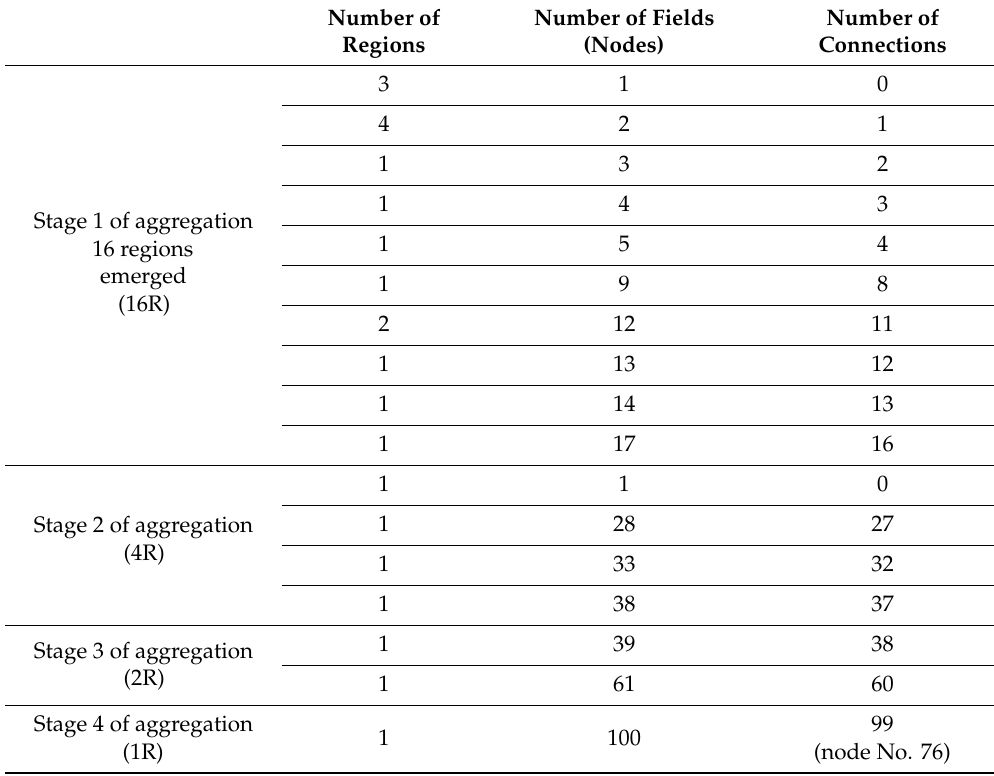
Table 4. Characteristics of the structure of networks formed according to the minimum value decrease path.